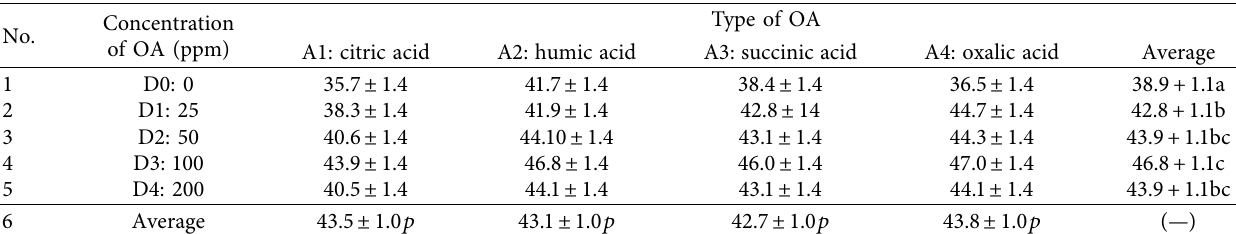
Figure 5: Efect of OAs application on PR on plant height of maize. At the same time observation (DAP), data followed by the same lowercase letters indicate that was no signifcantly diferent among the treatments on OAs type and OAs concentration at p ≥ 0 . 05. Table 8: Efect of OAs application on yield of maize.